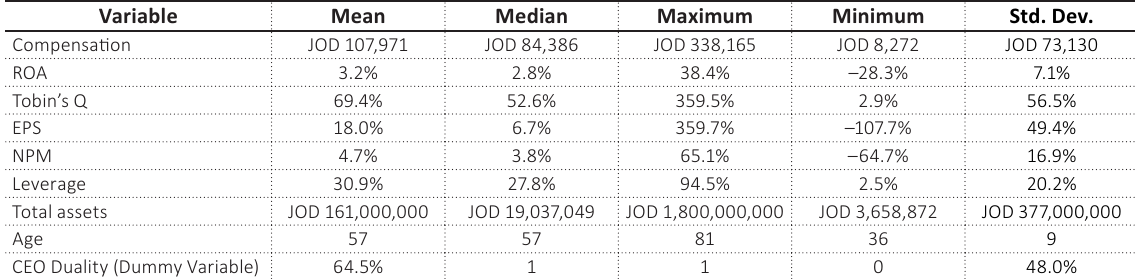
Table 2. Summary statistics of the